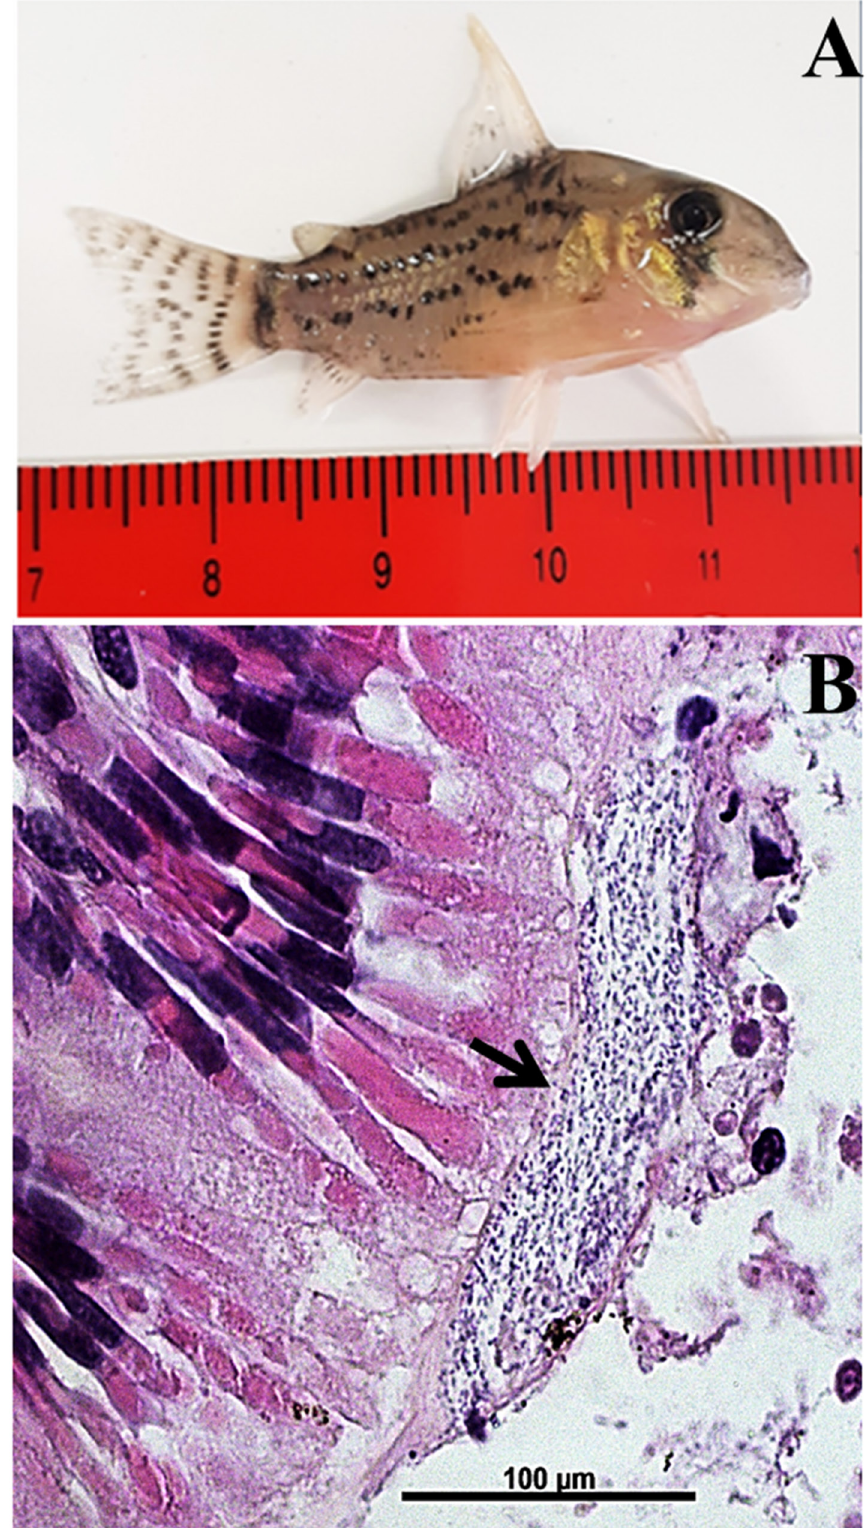
Fig. 1. Corydoras schwartzi Rössel, 1963 infected by Myxobolus adrianoi sp. nov. A . Sampled fish captured in the Purus River near Lábrea Municipality, Amazonas State, Brazil. B . Histological sections of the fish intestine showing large cyst in the serosa layer (black